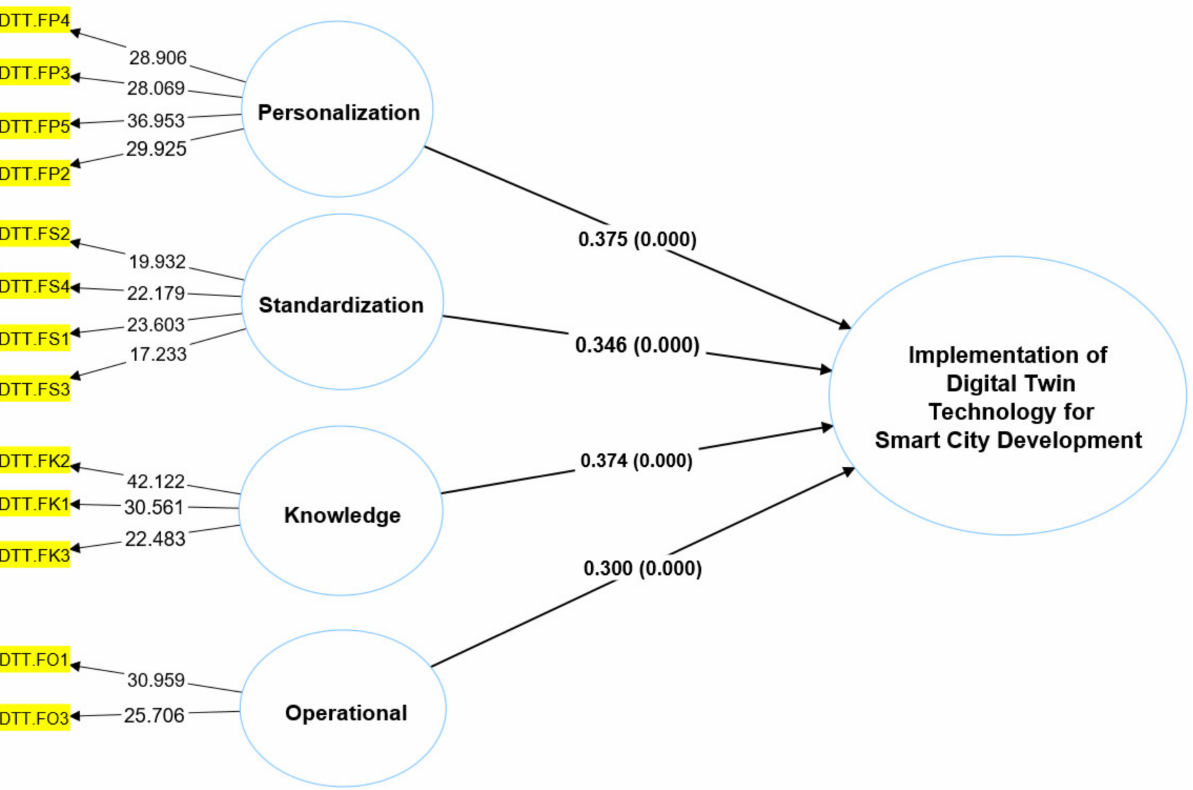
Figure 5. Structural model after bootstrapping analysis with path coefficients and significance.